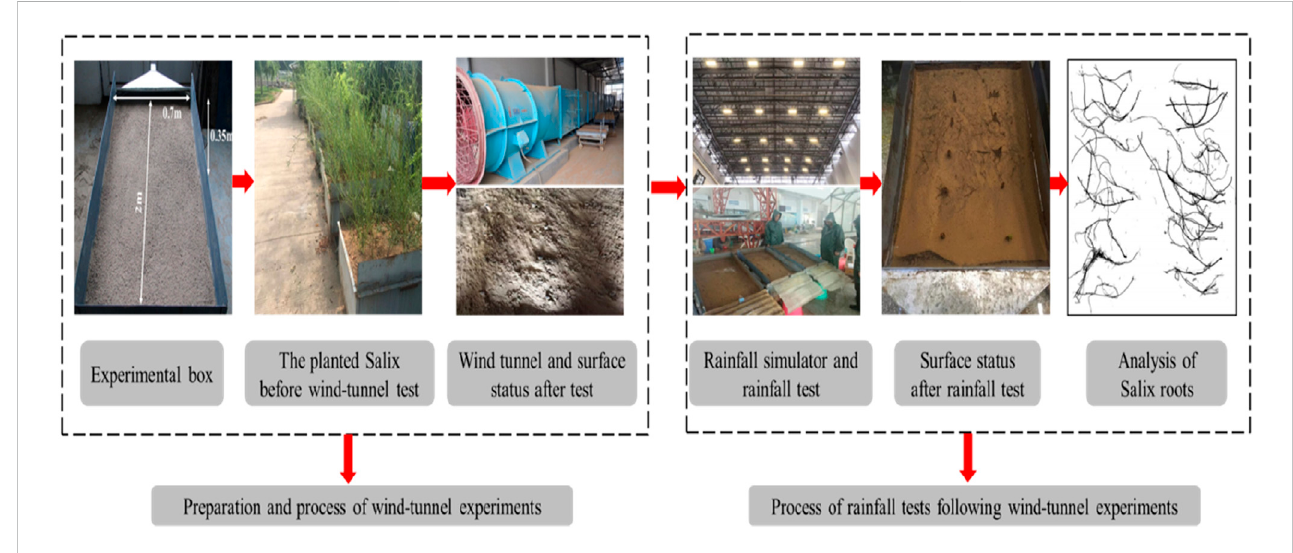
Schematic diagram of the experimental procedure in wind tunnel – rainfall